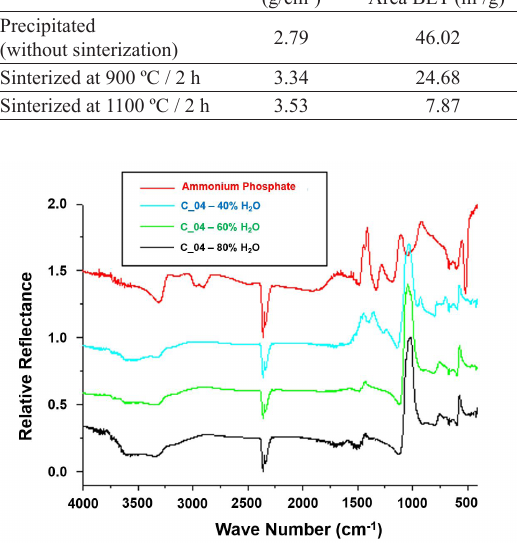
Table 3. Density and specific surface area of MgO powders precipitated and sinterized at different temperatures MgO